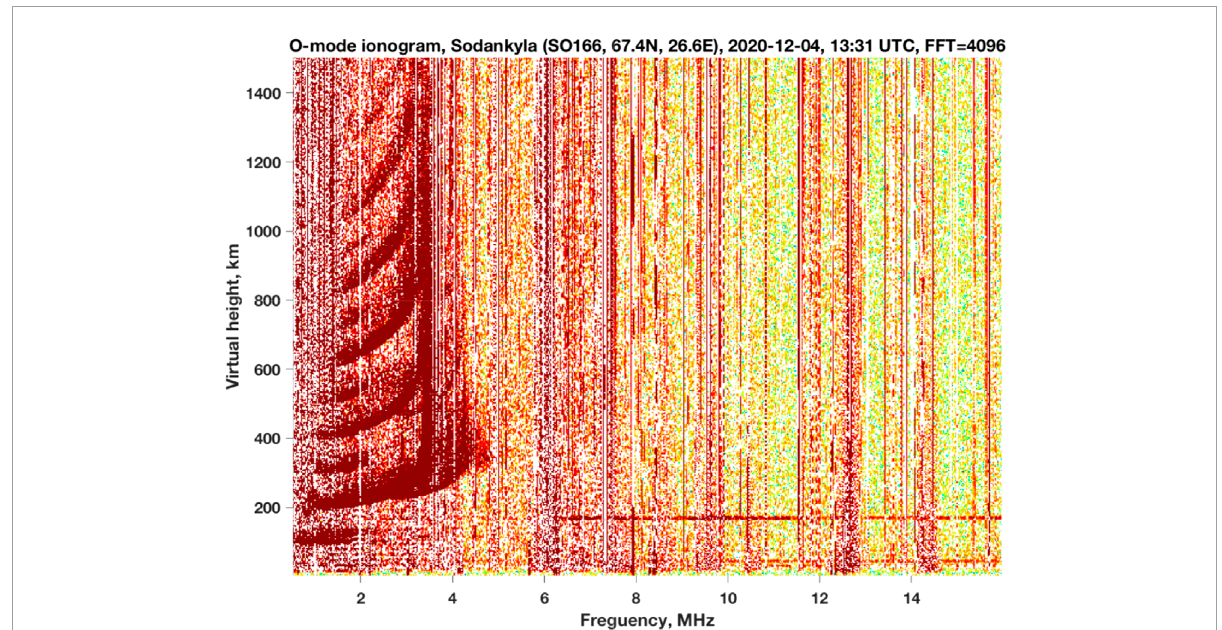
FIGURE 12 Mono-static ionogram measured at 13:31 UTC using the Sodankylä Geophysical Observatory “Alpha Wolf” ionosonde.